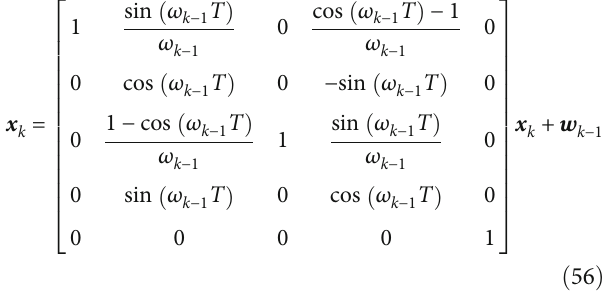
Figure 3: Averaged RMSEs with di ff erent